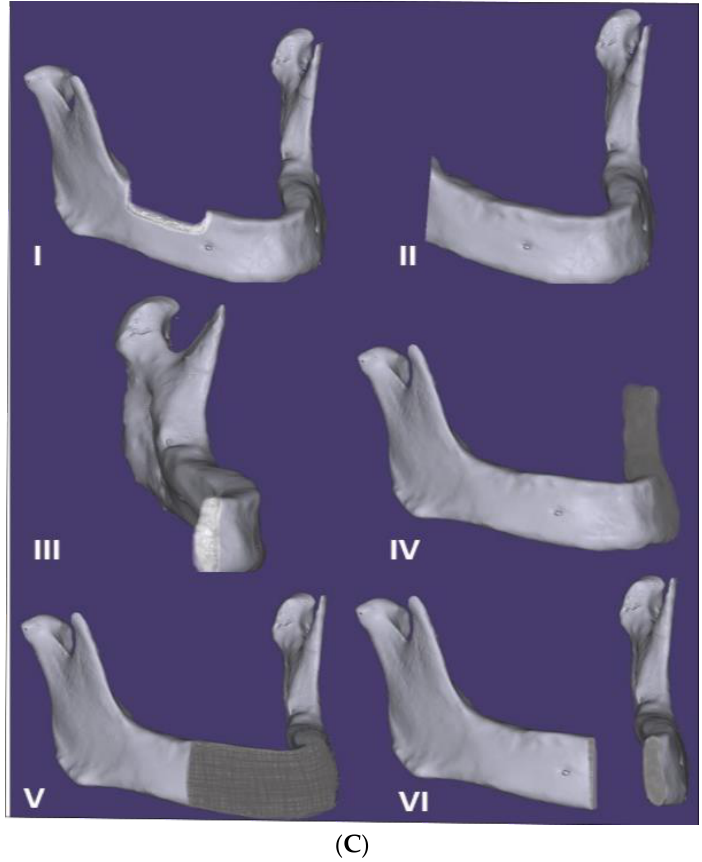
Figure 1. ( A ) Classification of the maxillofacial defects in extraoral, complex and intraoral cases (including extraoral complex and intraoral prostheses). ( B ) The intraoral maxilla and midface defects, classified according to Brown and Shaw classification in six classes [8]: vertical classification, with a maxillectomy not causing an oronasal fistula ( I ); not involving the orbit ( II ); involving the orbital adnexae with orbital retention ( III ); with orbital enucleation or exenteration ( IV ); with an orbitomaxillary defect ( V ); and with a nasomaxillary defect ( VI ), and for horizontal classification, only a palatal defect not involving the dental alveolus ( a ); less than or equal to a half unilateral ( b ); less than or equal to a half bilateral or transverse anterior ( c ); a greater than half maxillectomy ( d ). ( C ) The intraoral mandibular defects, classified according to Cantor and Curtis classification in six classes [10,11]: radical alveolectomy with preservation of mandibular continuity ( I ); lateral resection of the mandible distal to the cusp area ( II ); lateral resection of the mandible to the midline ( III ); lateral bone graft and surgical reconstruction ( IV ); anterior bone graft and surgical reconstruction ( V ); and anterior mandibular resection without surgical reconstruction ( VI ).